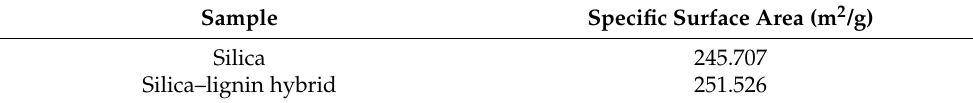
Table 5. Specific surface area of silica and silica–lignin hybrid using BET method analysis.